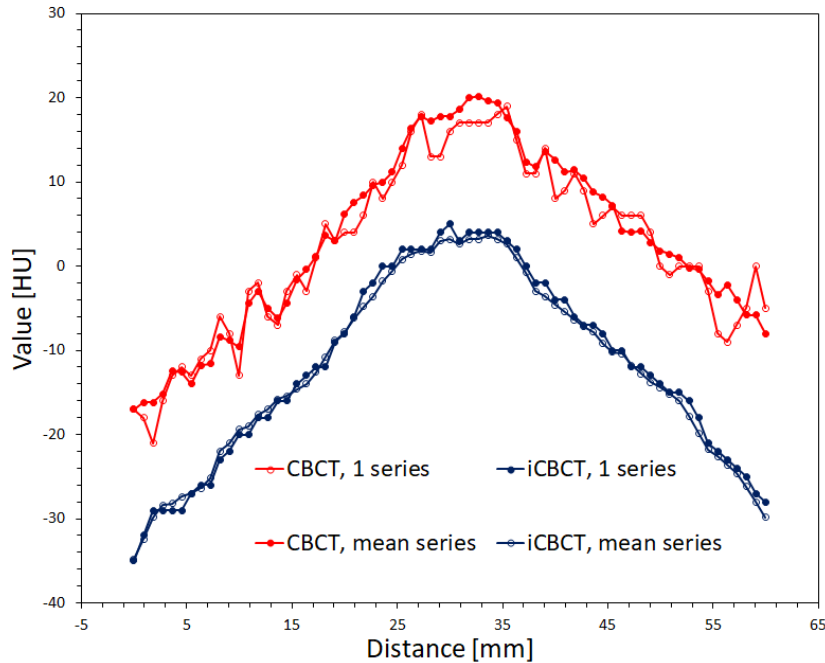
Figure 2. Profiles (as indicated in Figure 1) across the irradiated PABIG nx in the PH-5-DD2 GeVero Co. container (1 × 1 cm 2 , 10,000 MU) for a sample scanned with the TrueBeam accelerator equipped with CBCT and iCBCT. The results are shown for 1 and 1–5 series as the mean. Averaging the results over five series slightly lowered Std for CBCT; however, it did not improve it substantially for iCBCT (Table 5, Figures 1 and 2). This means that signal averaging for iCBCT is not a must, as it did not markedly improve image uniformity. One scan can be enough for iCBCT, which is advantageous in terms of reducing the overall scan